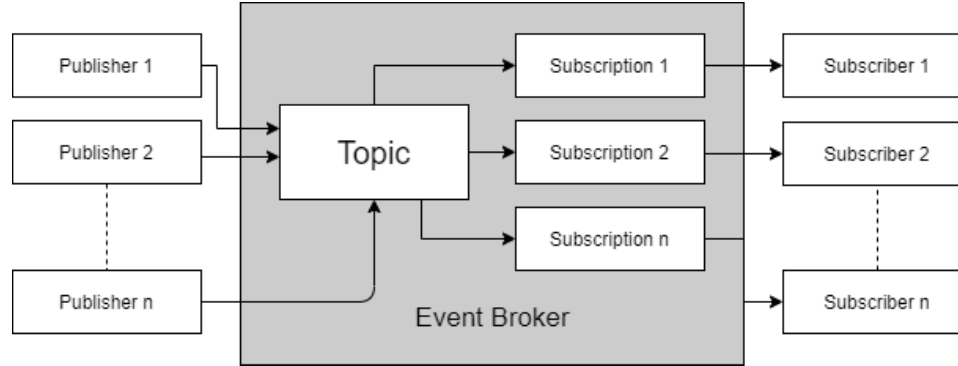
Figure 1. Overall architecture of a Pub/Sub system.